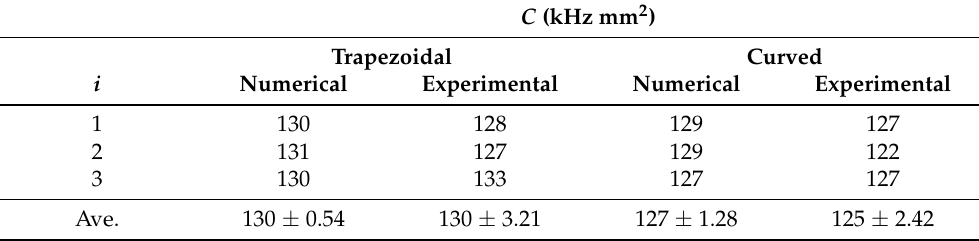
Table 3. Constant values C in Equations (5) and (8) derived from the Euler–Bernoulli theory. They can all be considered constant, and the theoretical predictions of frequency selectivity are clearly con- firmed.